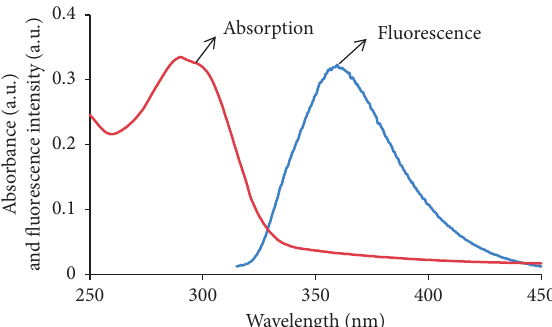
Figure 2: UV absorption and emission spectra of the ligand in acetonitrile-water (1:1). Ligand concentrations are 2.6 × 10 − 5 M and 2.0 × 10 − 7 M for absorption and emission spectra, respectively. The excitation wavelength is